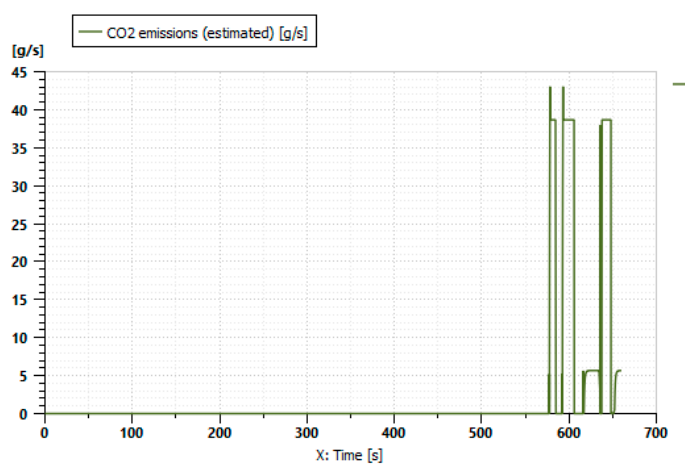
Figure 28. The variation in the CO 2 release.